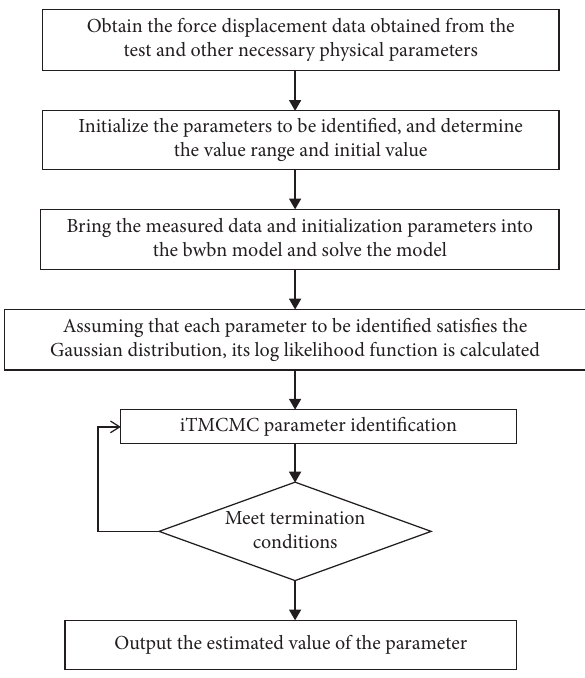
Figure 2: Calculation fow chart. Table 1: Parameter sampling